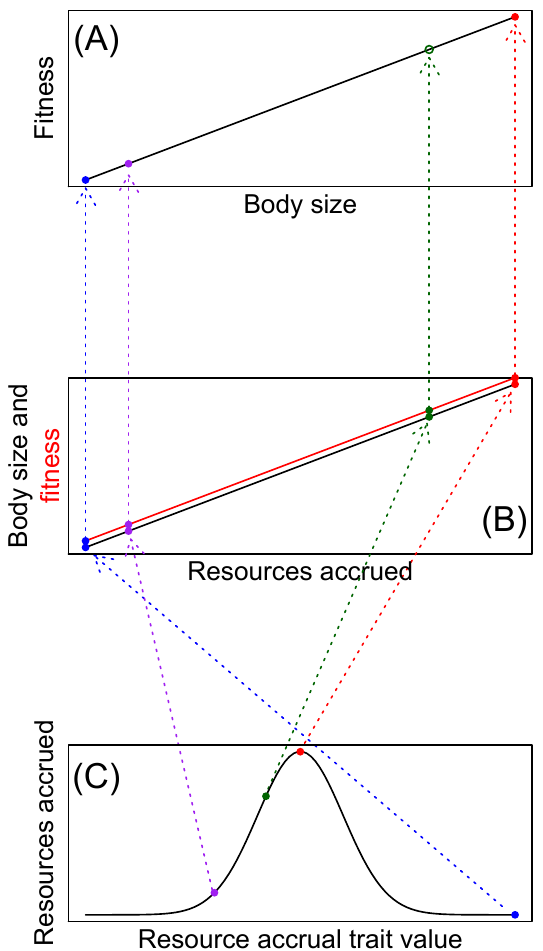
Figure 4. (A) A positive association between body size and fitness arises as (B) individuals that accrue most resources are larger and have higher fitness, which (C) is due to an n-shaped association between resource accrual and the resource accrual trait values. The dotted lines help visualize the map across